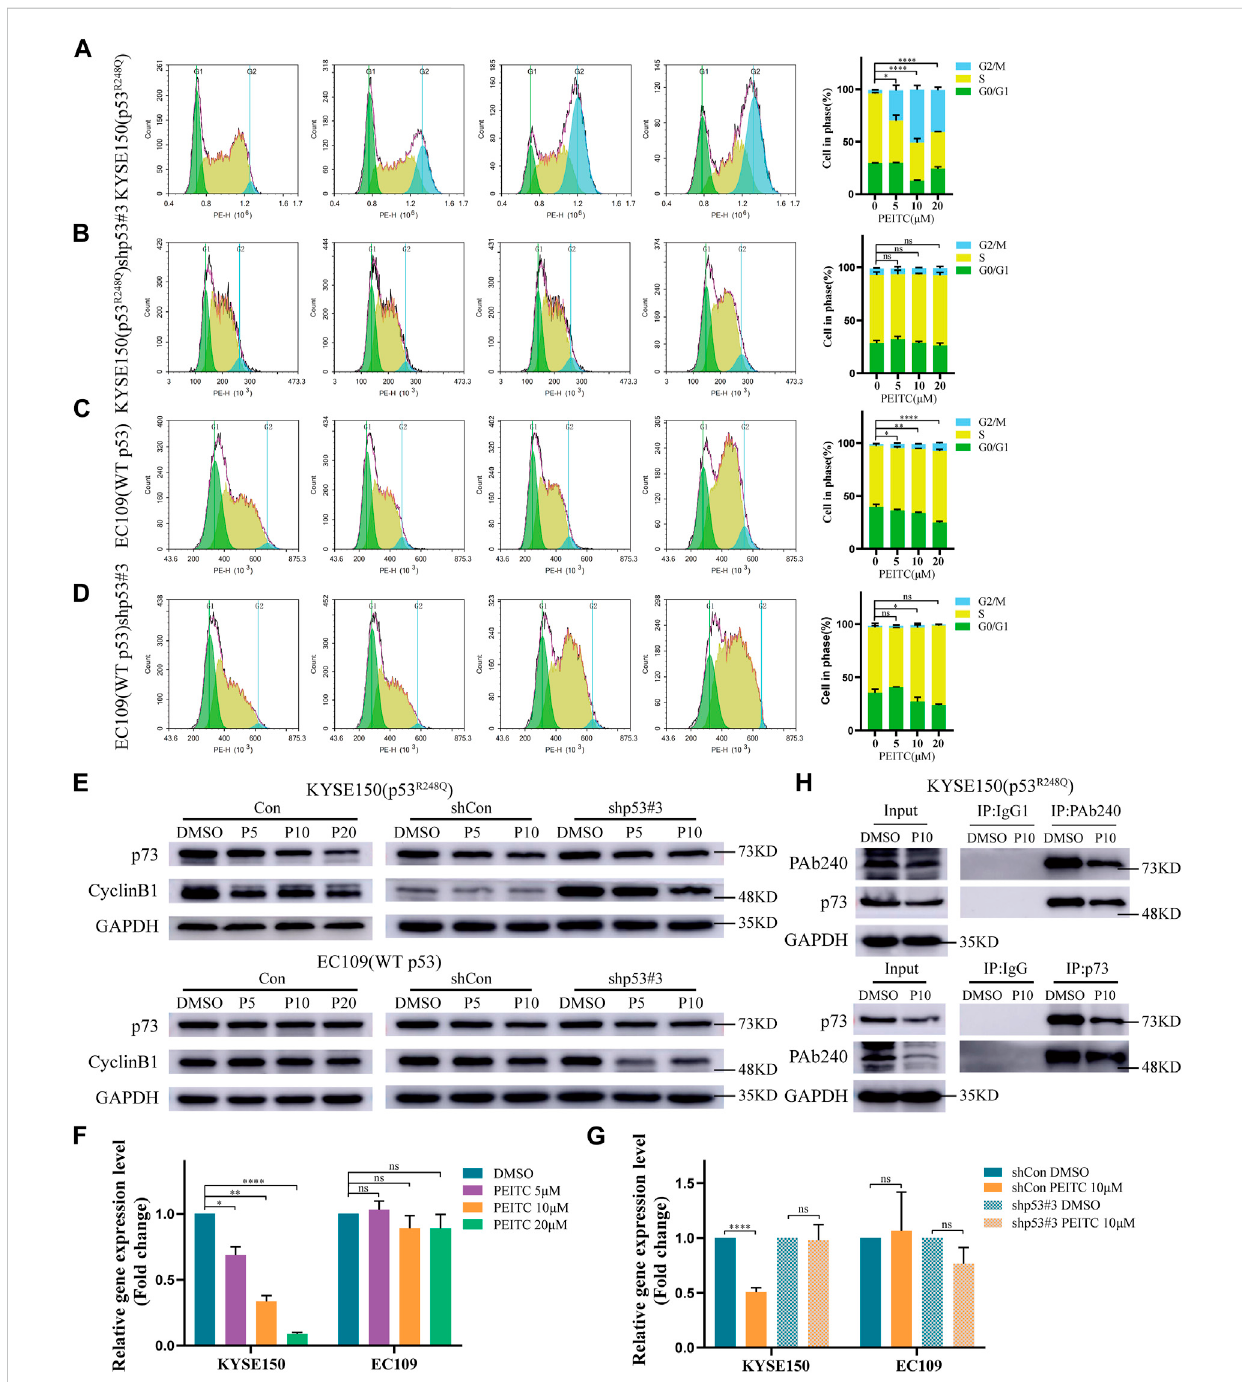
FIGURE 4 PEITC induces cell cycle arrest and the role of p73 in PEITC reactivation of p53 R248Q . (A – D) The cell cycle was detected by fl ow cytometry. (E) The expression levels of p73, CyclinB1 and GAPDH proteins were measured by Western blot analysis. (F, G) mRNA expression level of p73. (H) CoIP assays con fi rming the interaction of the p53 mutant with p73 in KYSE150 cell lines. * p < 0.05; ** p < 0.01; **** p < 0.0001. P5, PEITC 5 μ M; P10, PEITC 10 μ M; P20, PEITC 20 μ M. The cell experiment was repeated three